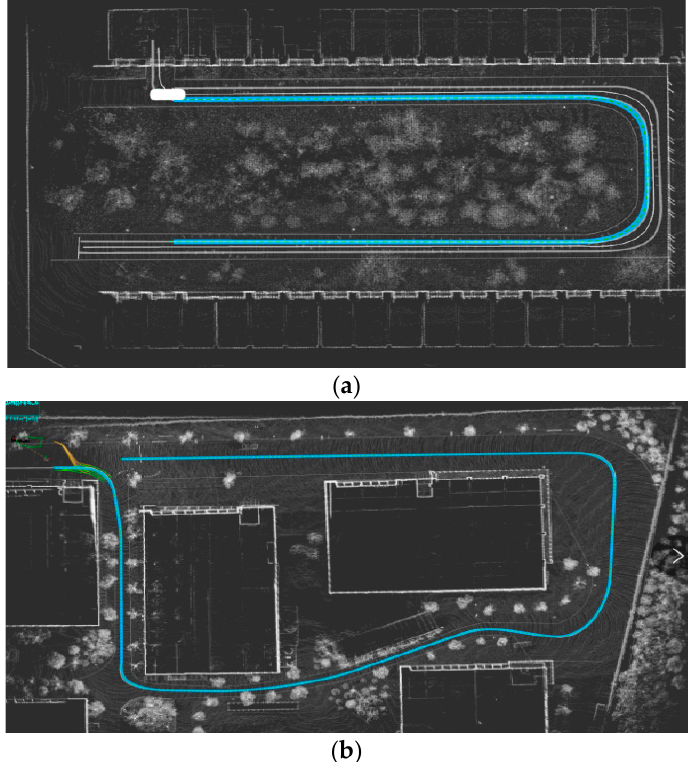
Figure 14. Global planning route. ( a ) Simple environment map; ( b ) complex environment map.